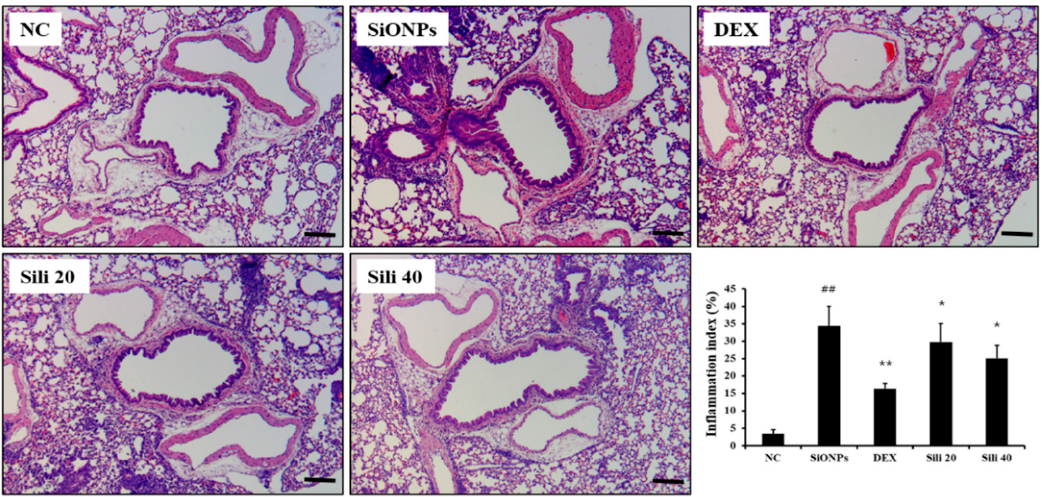
Figure 6. E ff ects of silibinin treatment on pulmonary inflammation caused by SiONPs exposure. A representative figure in the lung tissue stained with hematoxylin and eosin ( × 200). Quantitative analysis of inflammatory response was determined by an image analyzer. Scale bars indicate 50 µ m. NC, normal control mice treated with PBS only; SiONPs, mice treated with SiONPs intranasal instillation; DEX, mice treated with dexamethasone (2 mg / kg) + SiONPs intranasal instillation; Sili 20 and 40, mice treated with silibinin (20 and 40 mg / kg, respectively) + SiONPs intranasal instillation. Data are represented as means ± SD ( n = 6). ## p < 0.01 vs. NC group, * , ** p < 0.05 and < 0.01 vs. SiONPs group, respectively.